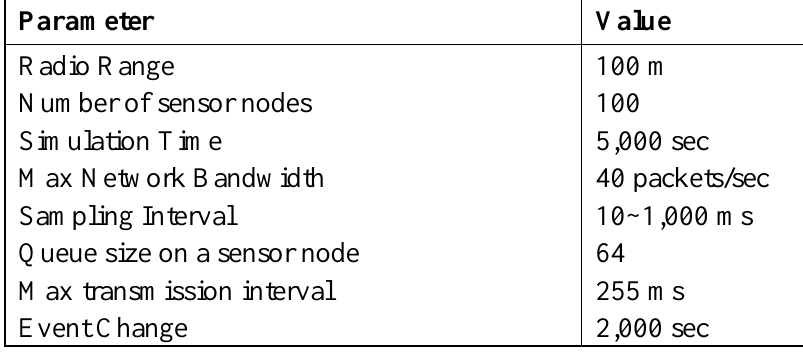
Table 1 . Specifications of simulation environment.